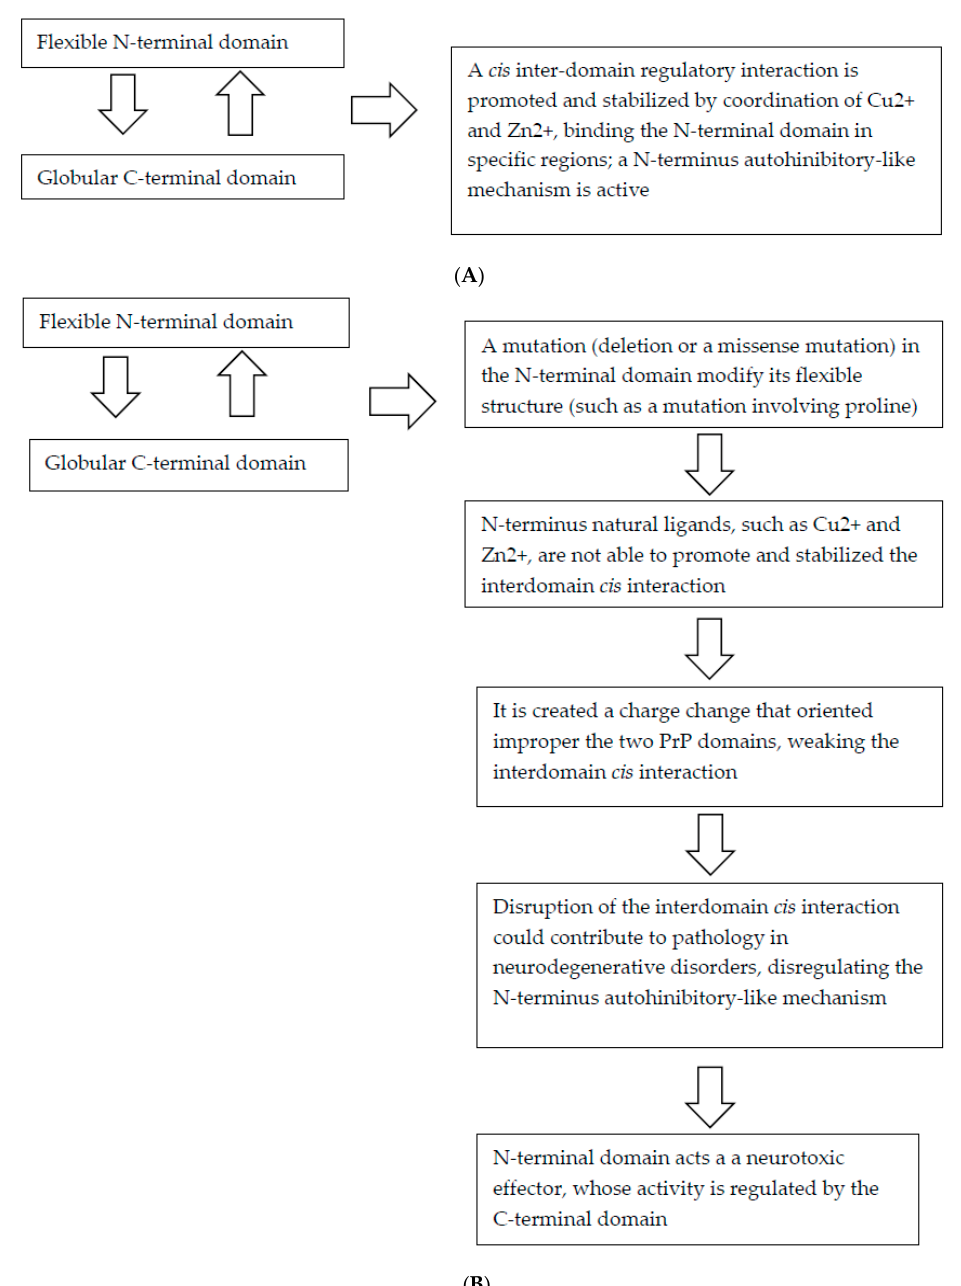
Figure 1. Flow chart depicting feedback loops involved in the physiological and pathological function of PrP. ( A ) The physiological function of PrP; ( B ) The hypothesized pathological mechanisms influencing the function of PrP.